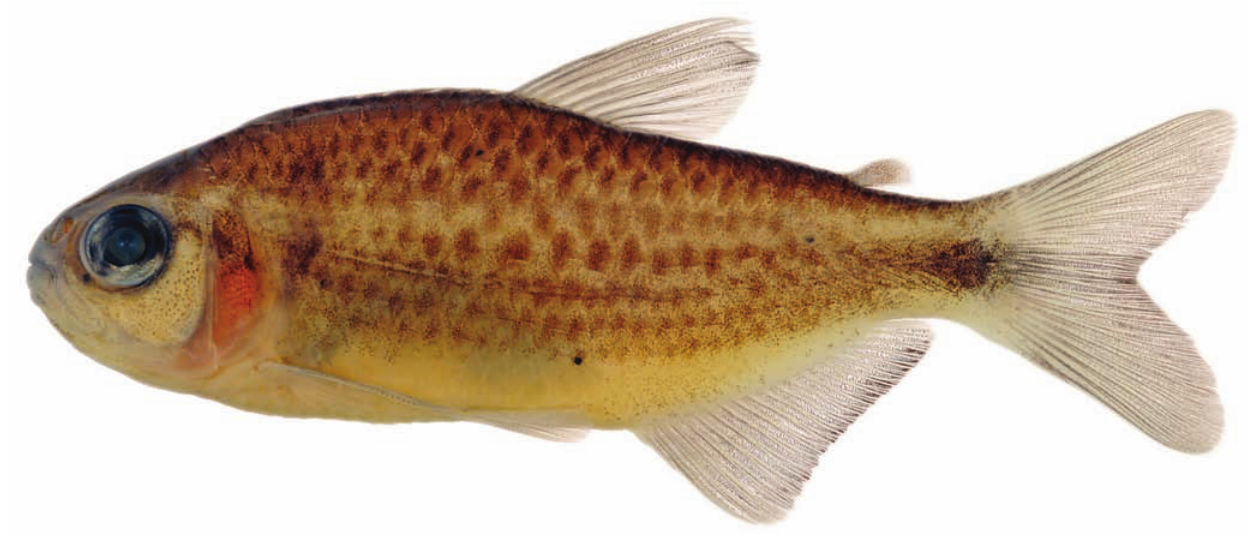
Fig. 6. Moenkhausia plumbea , holotype, MZUSP 99415, 49.5 mm SL, Brazil, Pará, Novo Progresso, tributary to rio Braço